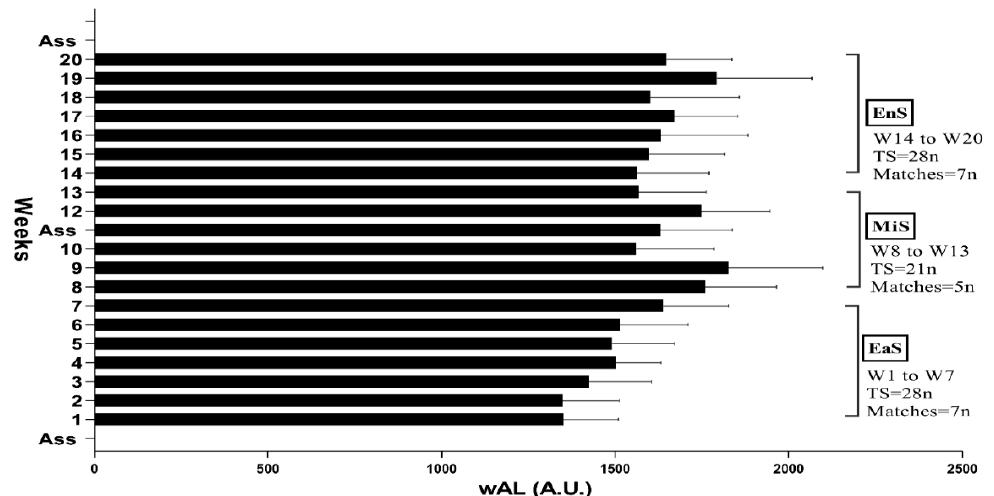
Figure 1. Research outline of the weekly monitoring on training and match load and assessed sessions during the competition season. EaS (early-season = before league for first study and W1 to W7 for the second study); MiS (mid-season = mid league for fist study and W8 to W13 for the second study); and EnS (end-season = after league for fist study and W14 to W20 for the second study); wAL = weekly acute workload; W = Week; TS = Training sessions; ASS = Assessments, and A.U. = Arbitrary unit. Descriptive characteristics of players are presented in Table 1 . Values are reported as mean ± SD.